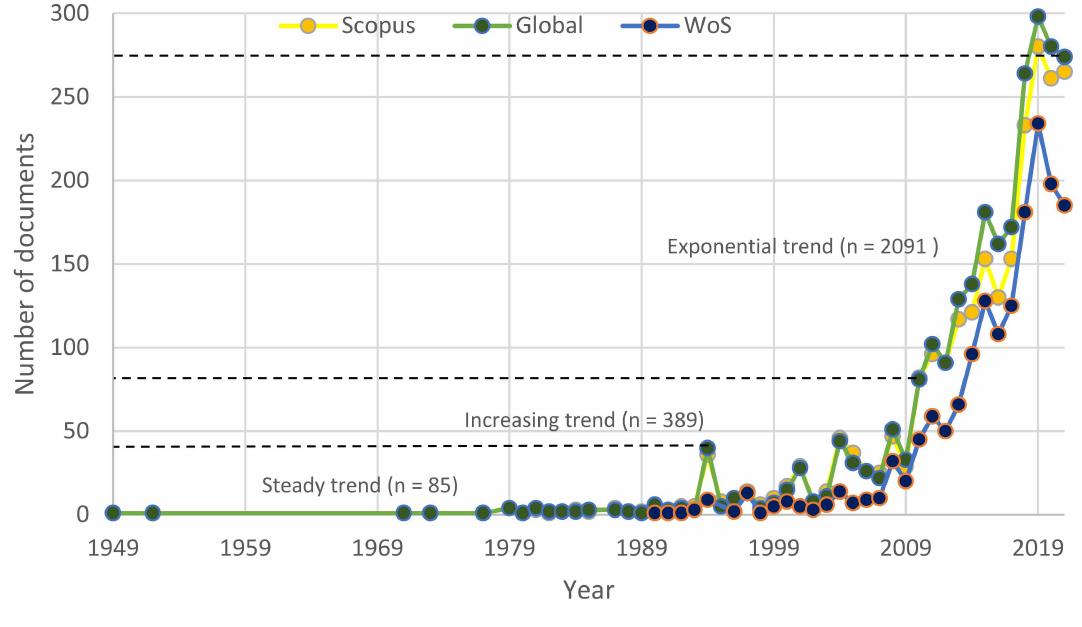
Figure 4. Trend of publications between geoheritage and geosites, using data from Scopus ( n = 2389 documents), WoS ( n = 1626), and Global database ( n =